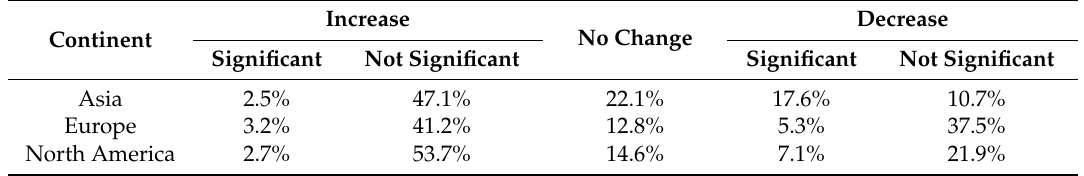
Table 3. Percent variation by area in Asia, Europe and North America based on the Mann–Kendall method. Increase Decrease No Change Continent Significant Not Significant Significant Not Significant Asia 2.5% 47.1% 22.1% 17.6% 10.7% Europe 3.2% 41.2% 12.8% 37.5% North